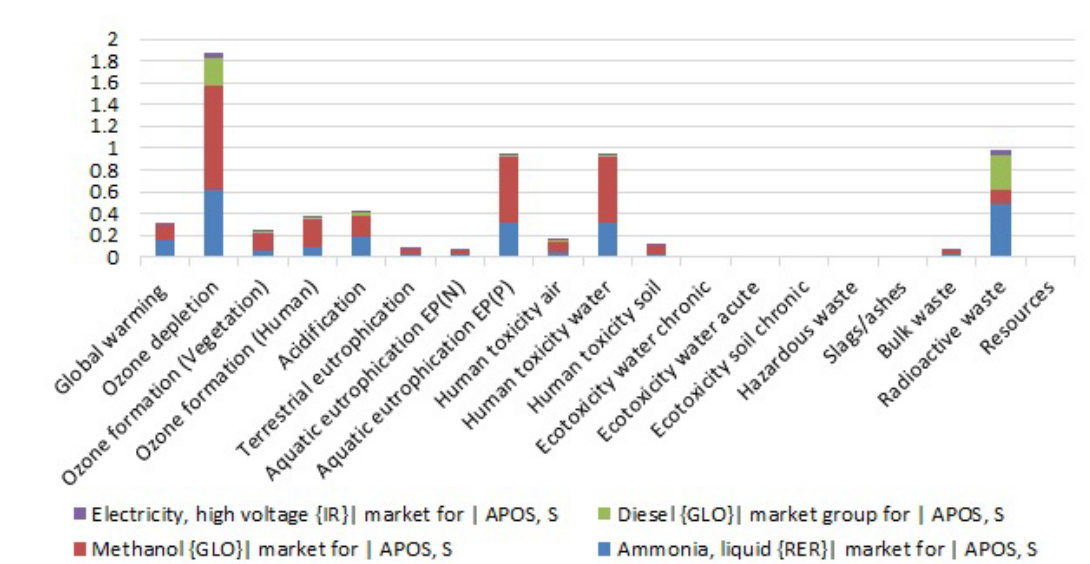
Figure 9. Results of applying weighting coefficients of EDIP 2003 method in calculating impacts